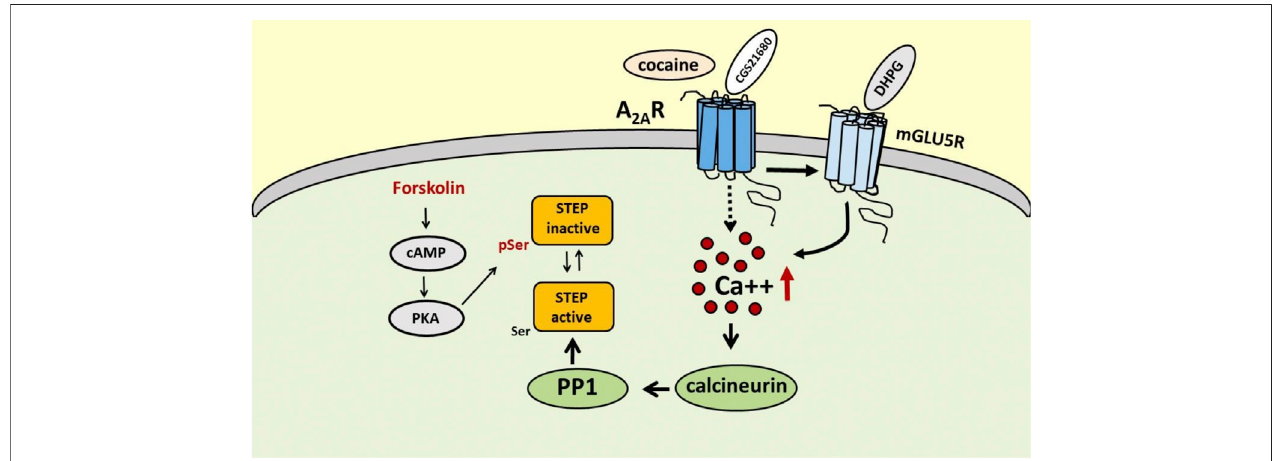
FIGURE 1 | Schematic representation of the possible mechanisms involved in the regulation of STEP activity by A 2A Rs. Activation of A 2A Rs, directly with the selective